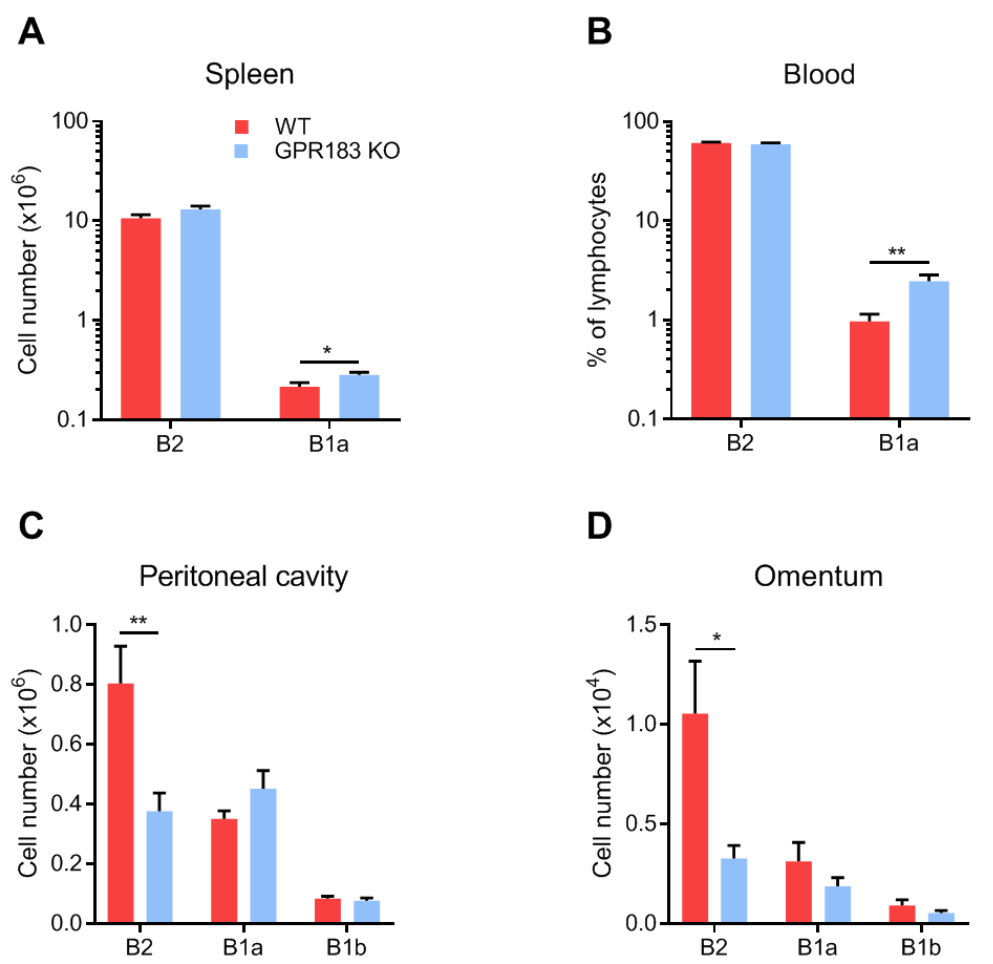
Figure 2. Numbers of B cells in different body compartments of GPR183 KO mice. Numbers or frequencies of cells of the indicated B cell subsets, as determined by flow cytometry. Quantification of cells from; ( A ) spleen; ( B ) blood; ( C ) peritoneal cavity; and ( D ) omentum from 9–19 GPR183 KO and WT mice, which were 11–37 weeks of age. In ( C ) and ( D ), data were pooled from four independent experiments. Error bars represent mean ± SEM. * p < 0.05 and ** p < 0.01 by unpaired Student’s t -test.